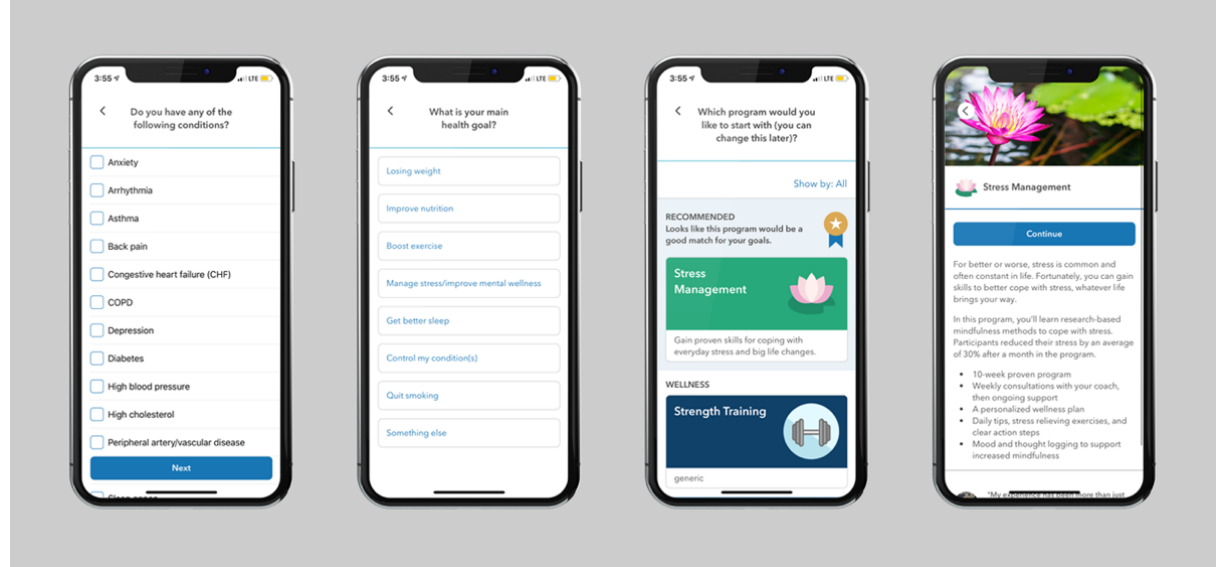
Figure 2. Program screens showing flow into the Vida Health mindfulness-based stress reduction program.